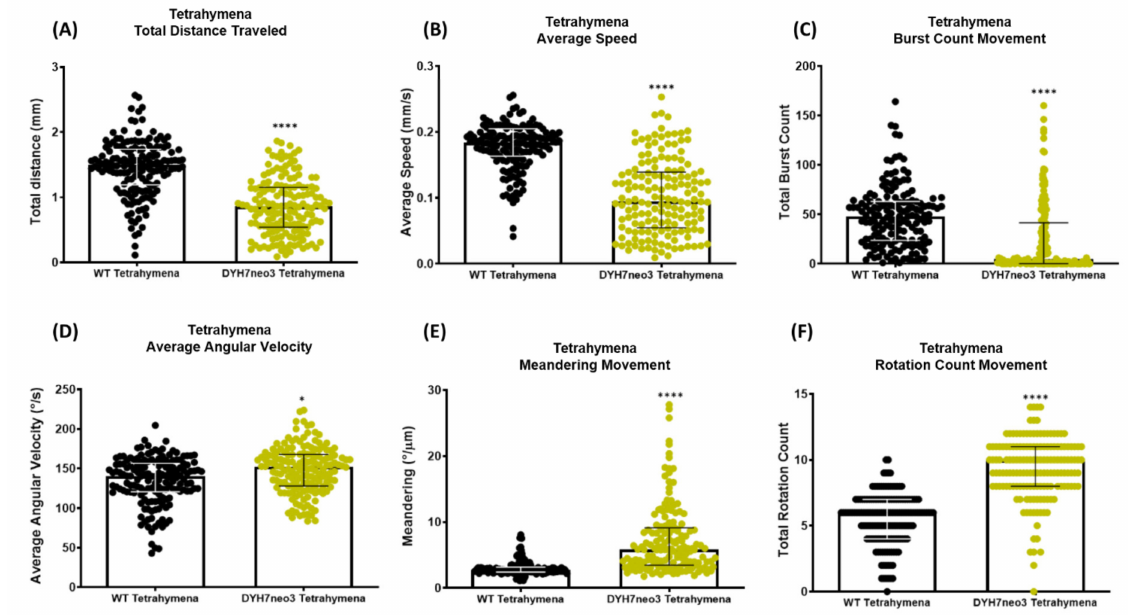
Figure 3. Comparison of locomotor activity between wild-type (CU428) and mutant (DYH7neo3) T. thermophila for 10 s. Six locomotor endpoints of ( A ) total distance traveled, ( B ) average speed, ( C ) burst movement, ( D ) average angular velocity, ( E ) meandering, and ( F ) rotation move- ment were statistically analyzed by Mann–Whitney test ( n = 158 for each group; * p value < 0.05; **** p value < 0.0001). Median and interquartile range are used to express the data. Cumulative trajectory paths are presented in Figure